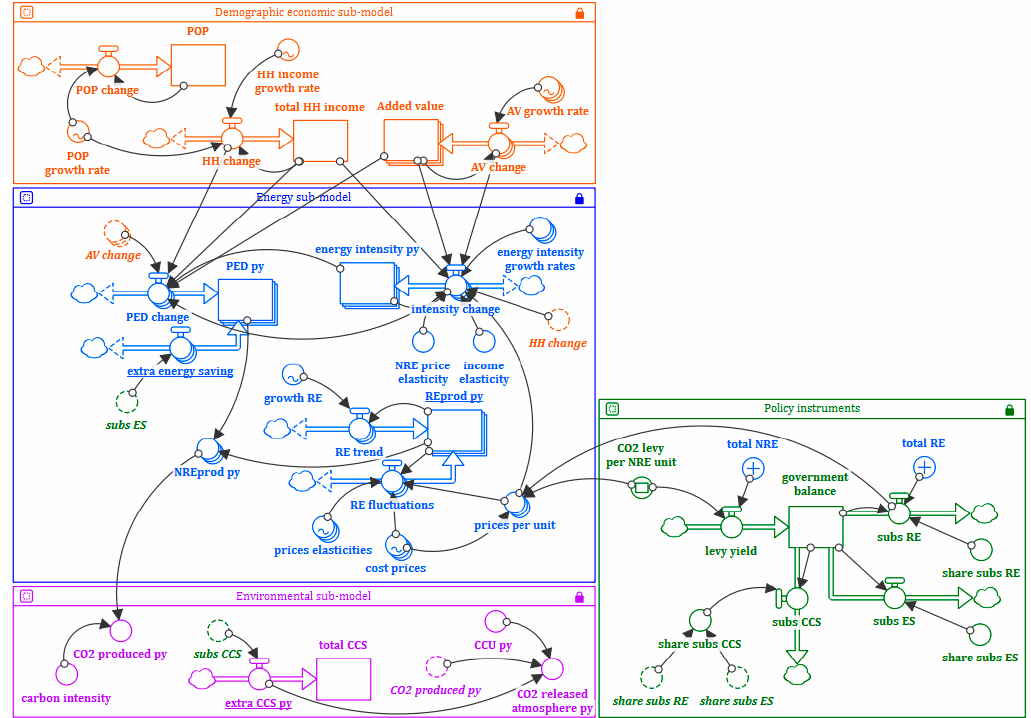
Figure 3. Scheme of the System Dynamics Model for Energy Policy in Stella software.